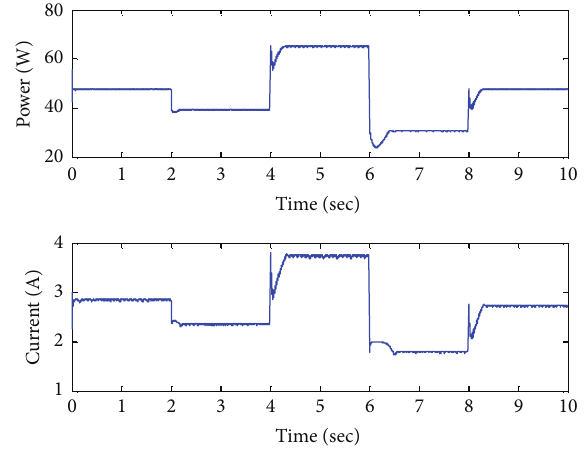
Figure 5: Measured input-output data for the PV